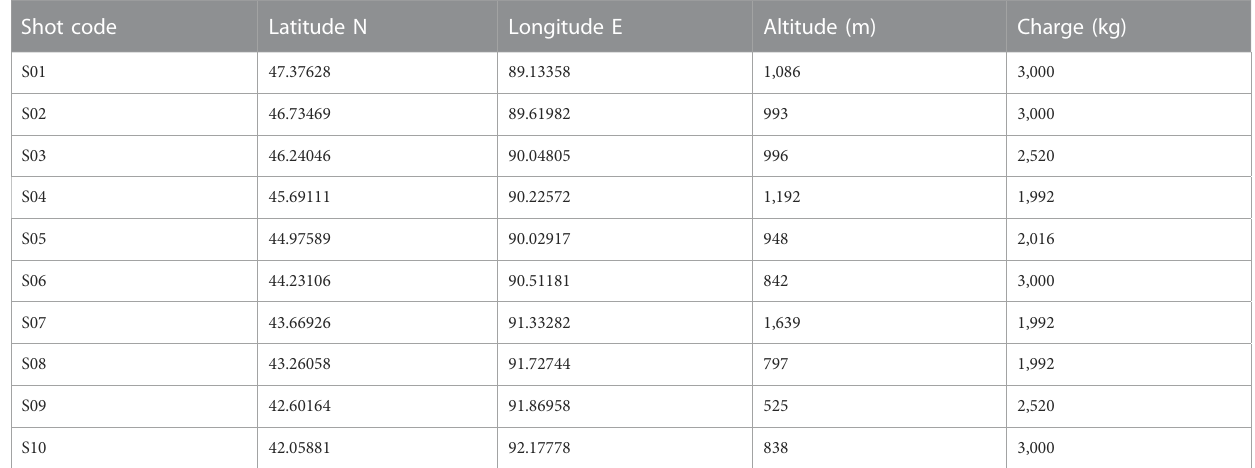
TABLE 1 Shot point locations and respective shot